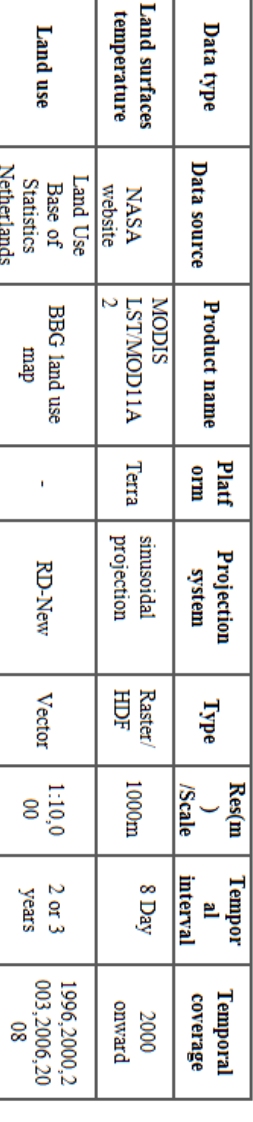
Figure 1. Overview of the datasets